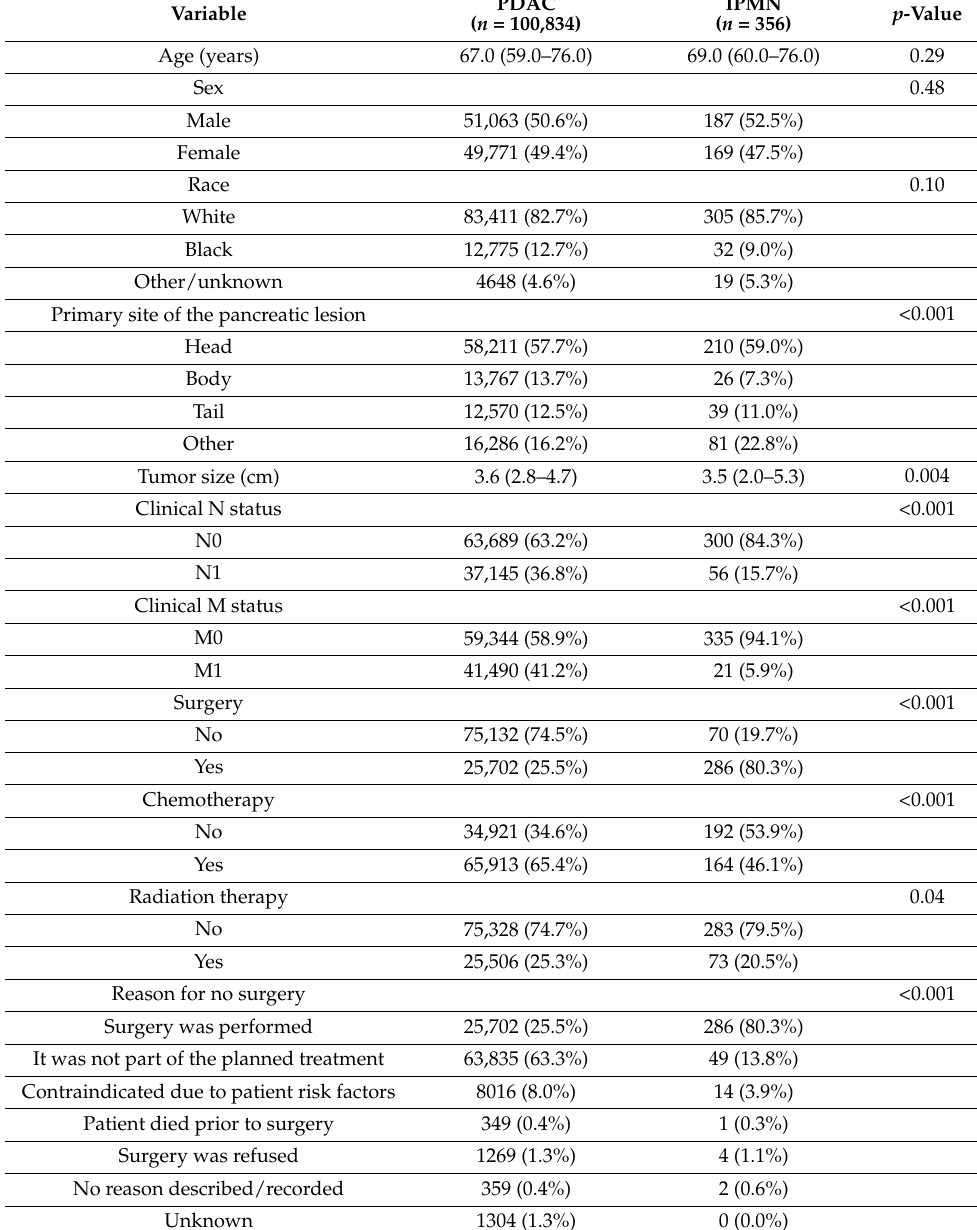
Table 1. Demographics by tumor type in all